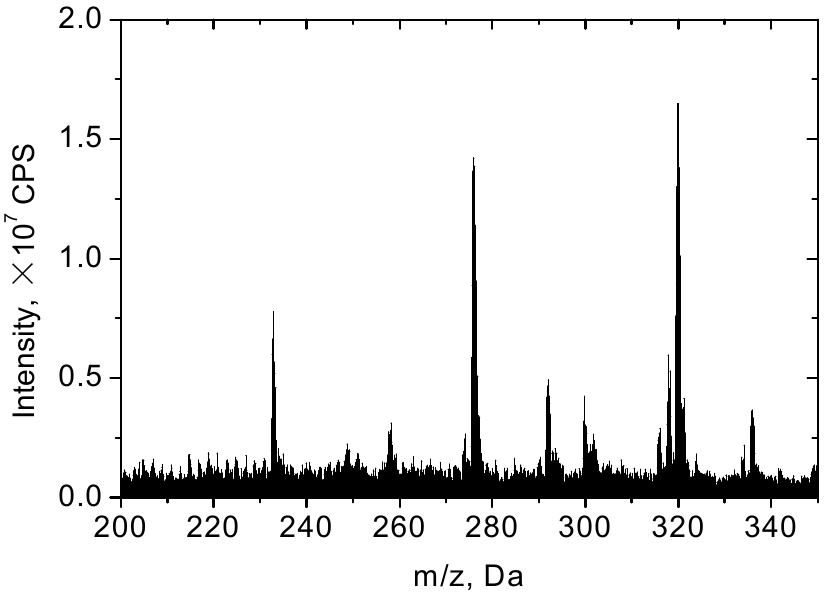
Figure 8. The MS spectra of NOR intermediates detected in sample withdrawn after 5 min of MW/UV reaction.